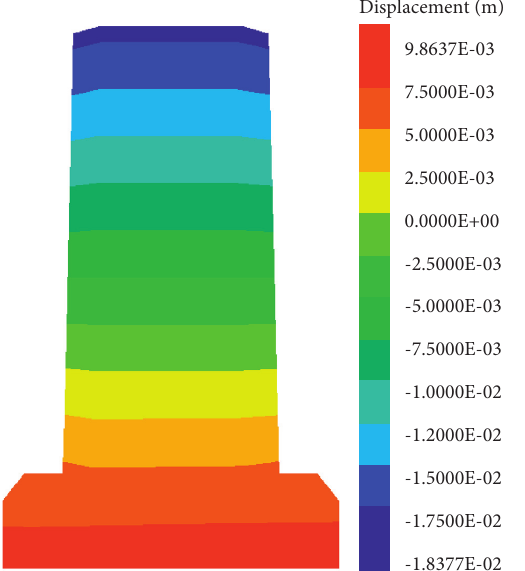
Figure 19: Cloud diagram of horizontal displacement of bridge cap.